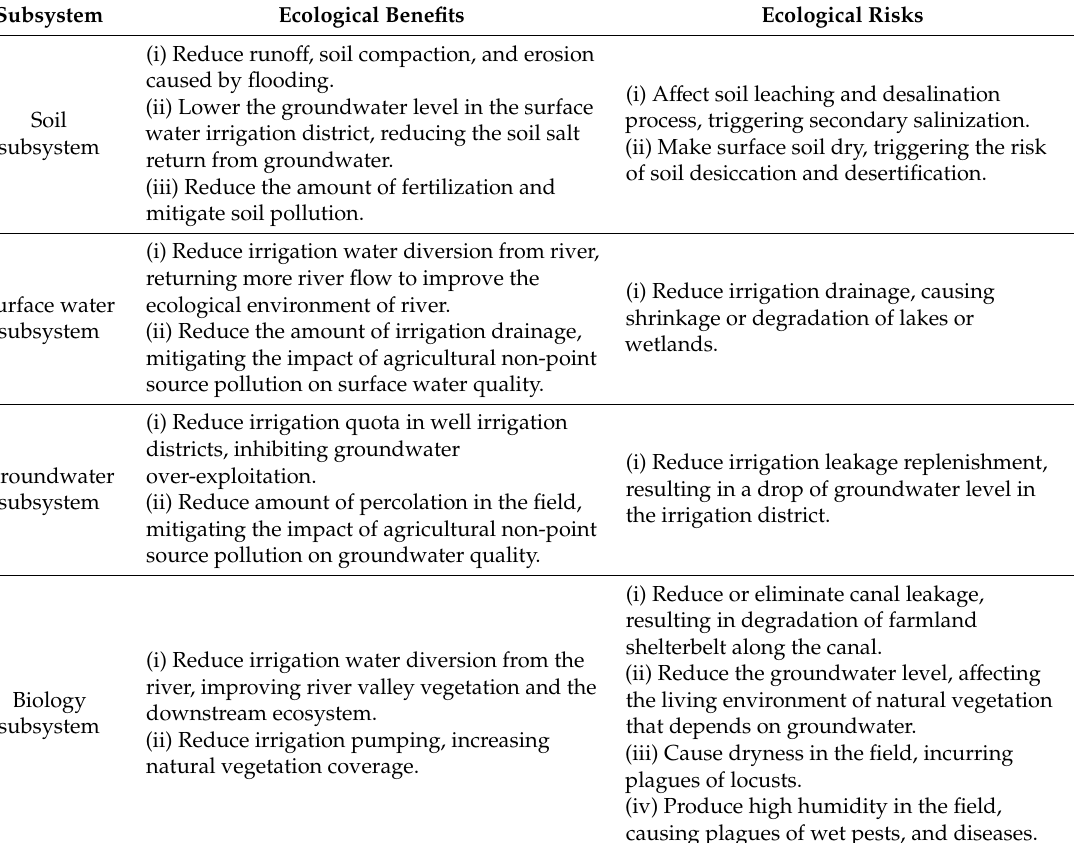
Table 6. Main ecological benefits and risks of water-saving